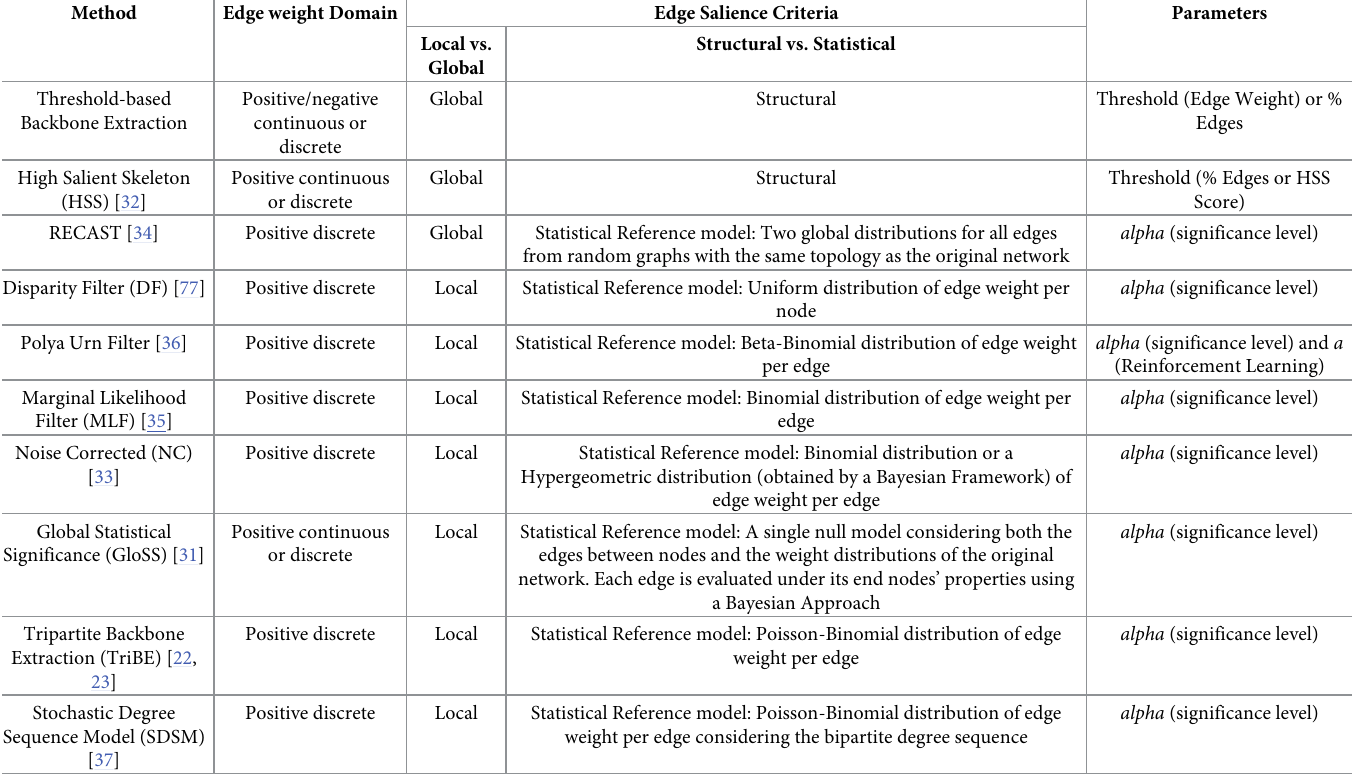
Table 1. Our characterization of selected backbone extraction